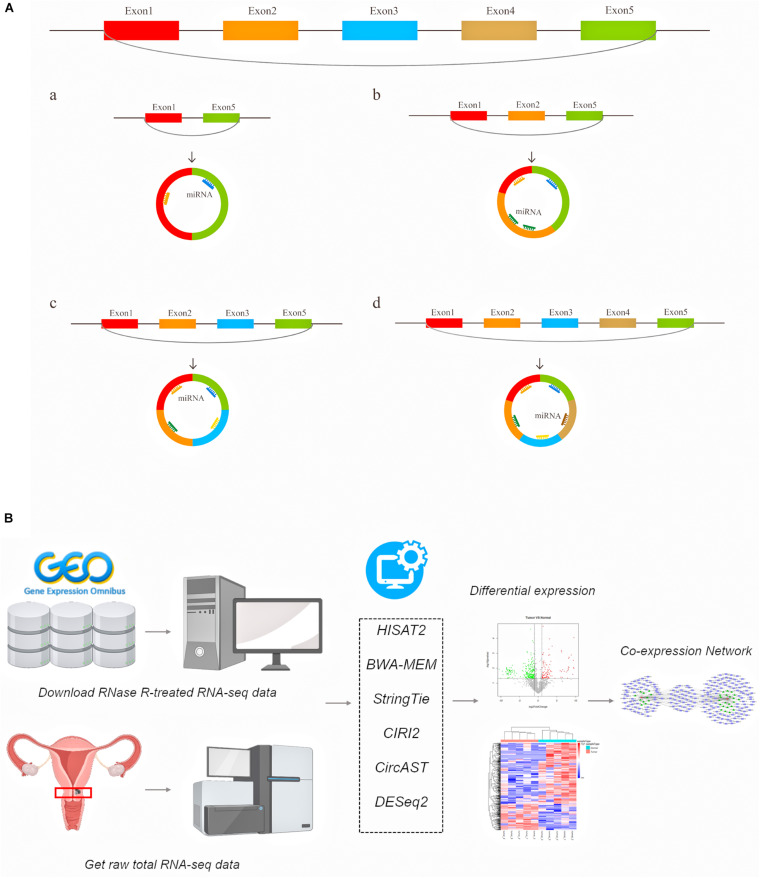
The schematic diagram of generated different circular RNA full-length transcripts in cervical cancer (A) and the flowchart of analyses in this study (B).